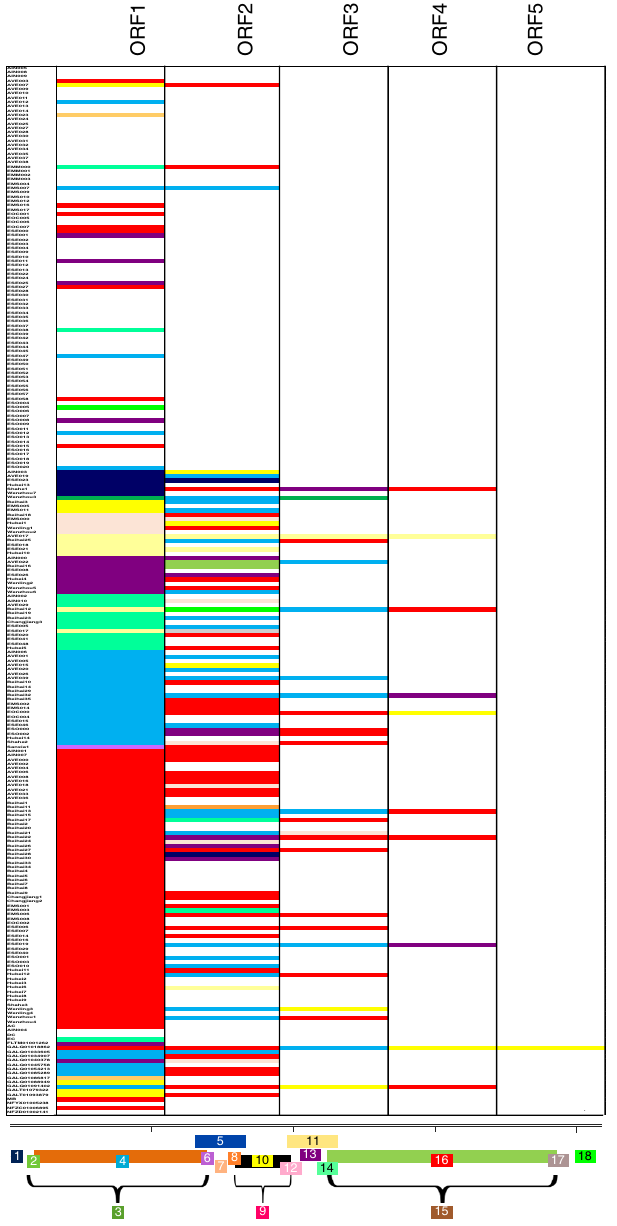
Fig. 3 Relative location of sgl -candidate ORFs. The number and relative location of sgl -candidate ORFs that were synthesized and tested per genome. The relative genomic locations (1 – 18) are shown on the canonical ssRNA phage genome and color coded as follows: 1 (navy blue), 2 (lime green), 3 (army green), 4 (teal blue), 5 (royal blue), 6 (orchid purple), 7 (tan), 8 (orange), 9 (bright pink), 10 (bright yellow), 11 (pale yellow), 12 (rose pink), 13 (dark purple), 14 (seafoam green), 15 (brown), 16 (red), 17 (gray), 18 (neon